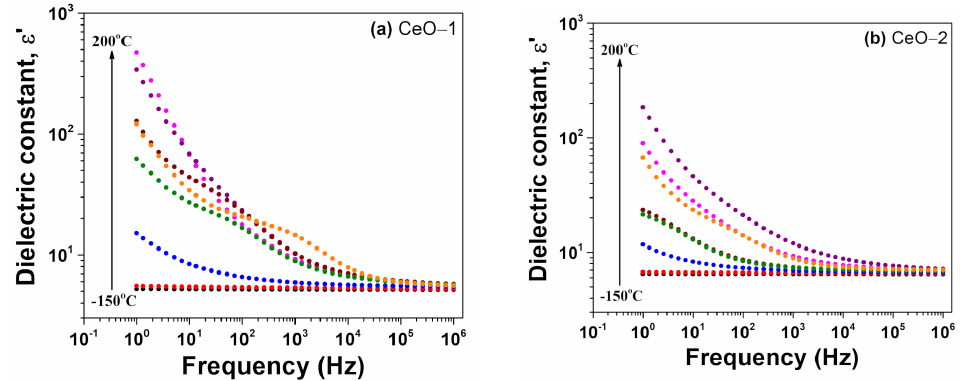
Figure 6. Variation of the dielectric constant as a function on frequency at different temperatures of cerium oxide nanoparticles: ( a ) CeO-1, ( b )